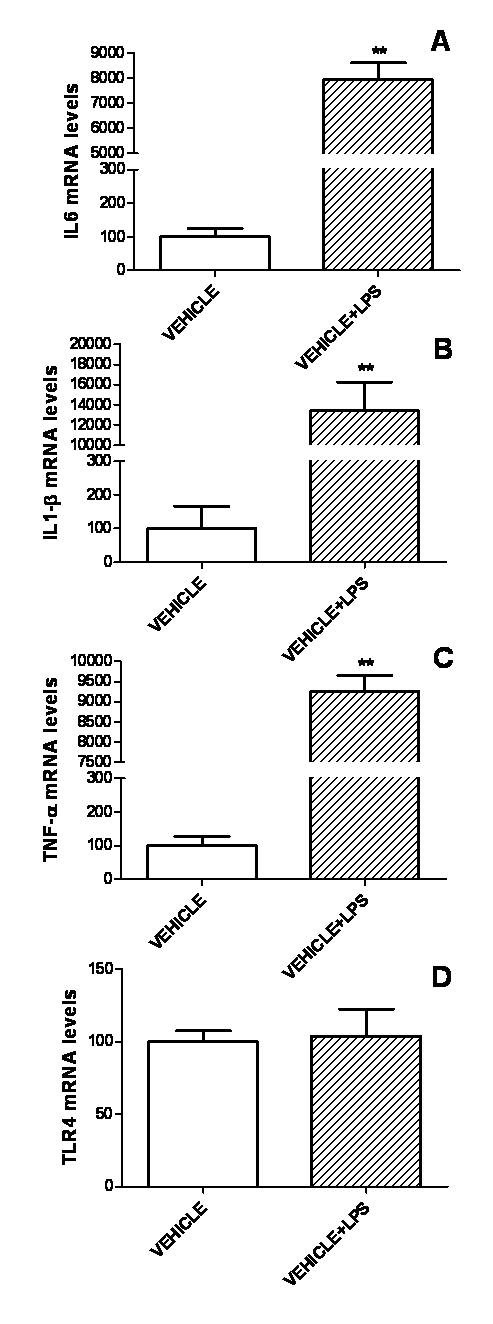
LPS increases expression of IL6, IL-1β, TNF-α and TLR4 in astrocytes. mRNA levels of IL6 (A), IL-1β (B), TNF-α (C) and TLR4 (D) in astrocytes treated for 5 h with LPS (500 ng/ml) or vehicle only. Data are presented as mean ± SEM and are expressed as percentage of control (vehicle) values. **,***, Significant differences (**P < 0.01; ***P < 0.001) in comparison to the values of cultures treated with vehicle.